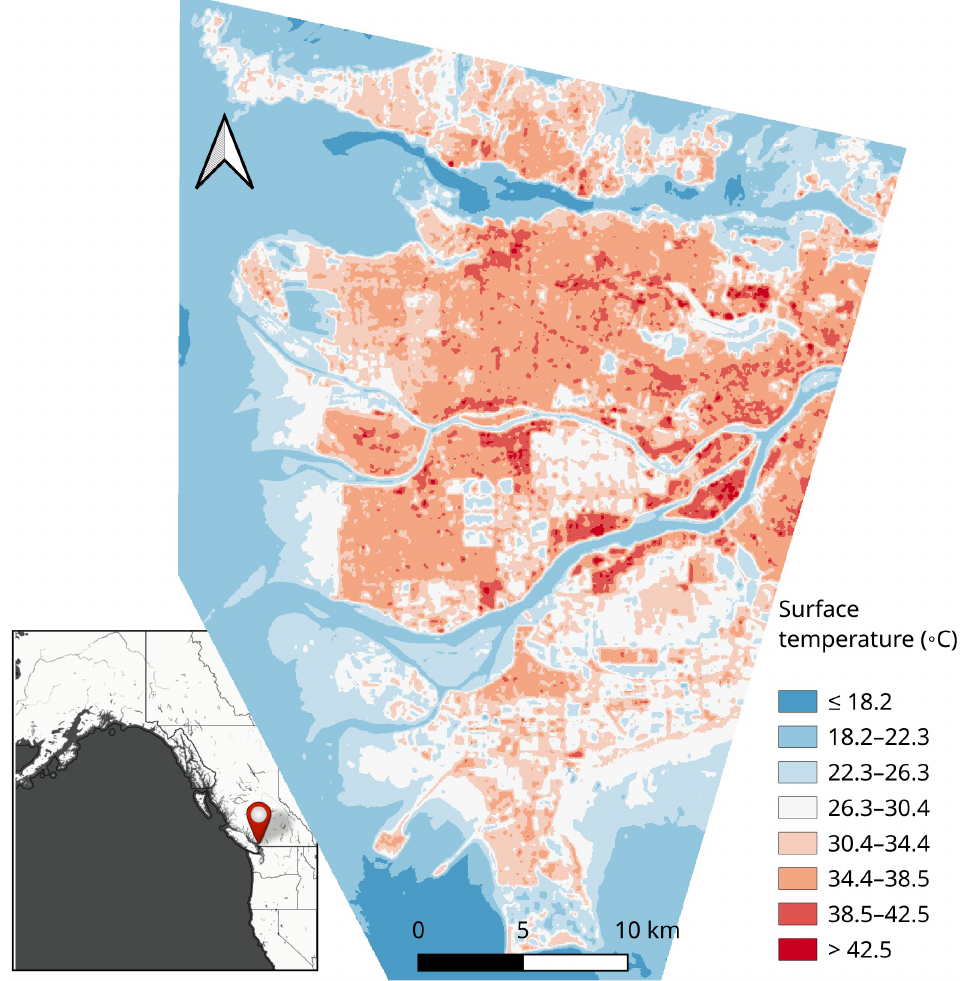
Figure 1. Map of the location of the study region (bottom left) and the bounds of the study region colored by the Landsat-derived surface temperature. Inset map © OpenStreetMap.org